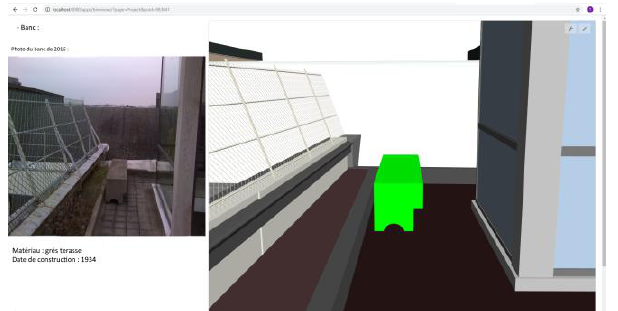
Figure 16. By clicking on the bench, information about it appear.